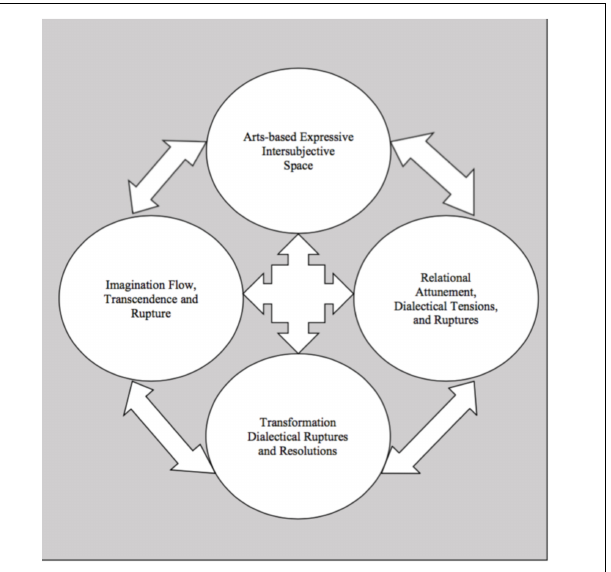
FIGURE 3 | Orbital system for dynamic